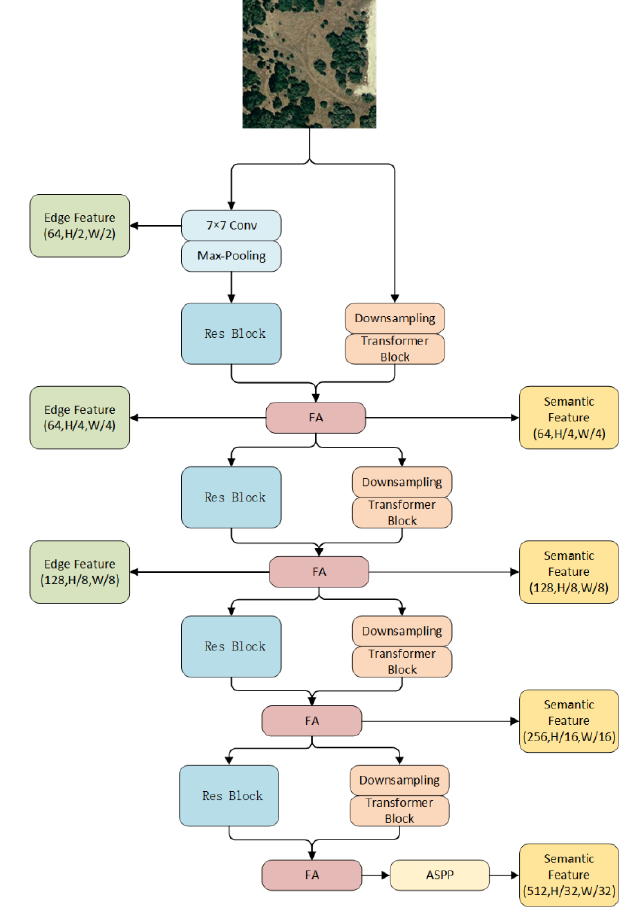
Figure 2. The details of the FE module. Res Block represents the Residual block, FA represents the feature aggregator, and ASPP is an atrous spatial convolution pooling pyramid.